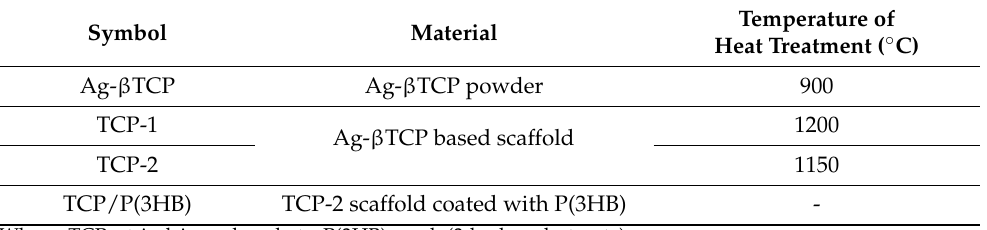
Figure 1. Bioceramic scaffolds coated with poly(3-hydroxybutyrate) (P(3HB)). Table 1. The description of studied materials.